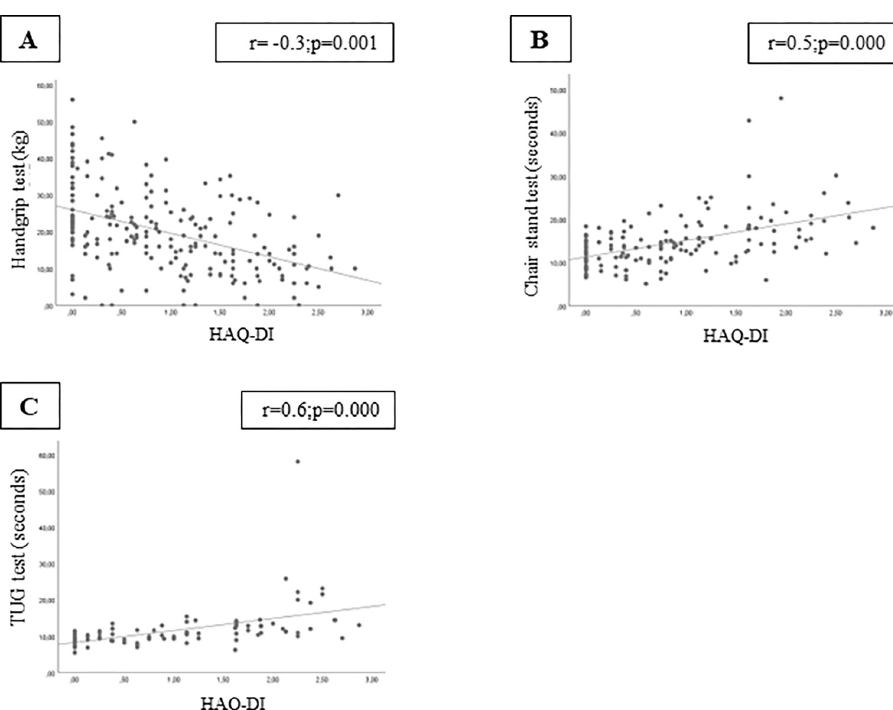
Fig 4. Correlation analysis was significant between HAQ-DI and (A) handgrip test, (B) chair stand test, and (C) TUG in the Brazilian cohort. Abbreviations: TUG, Timed-up-and-go test; kg, kilogram; sec, seconds.